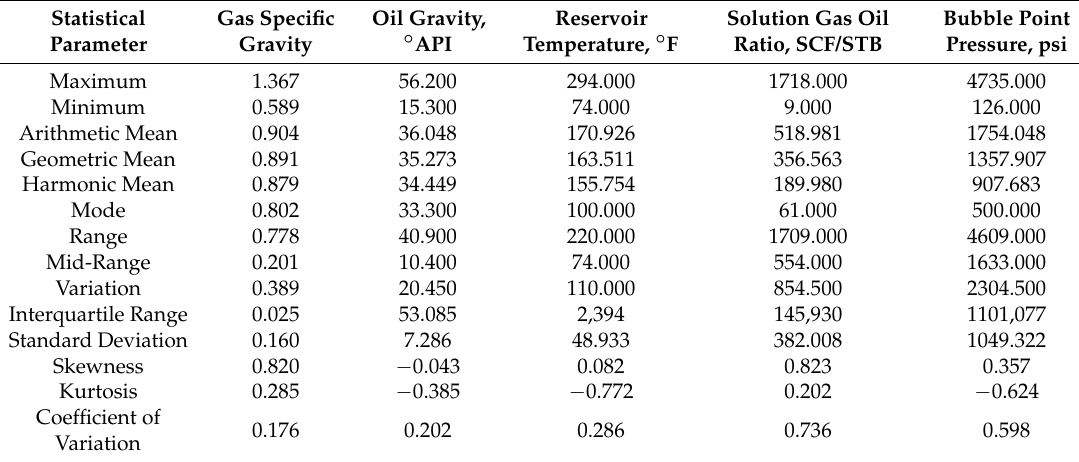
Table 1. Statistical parameters for the studied